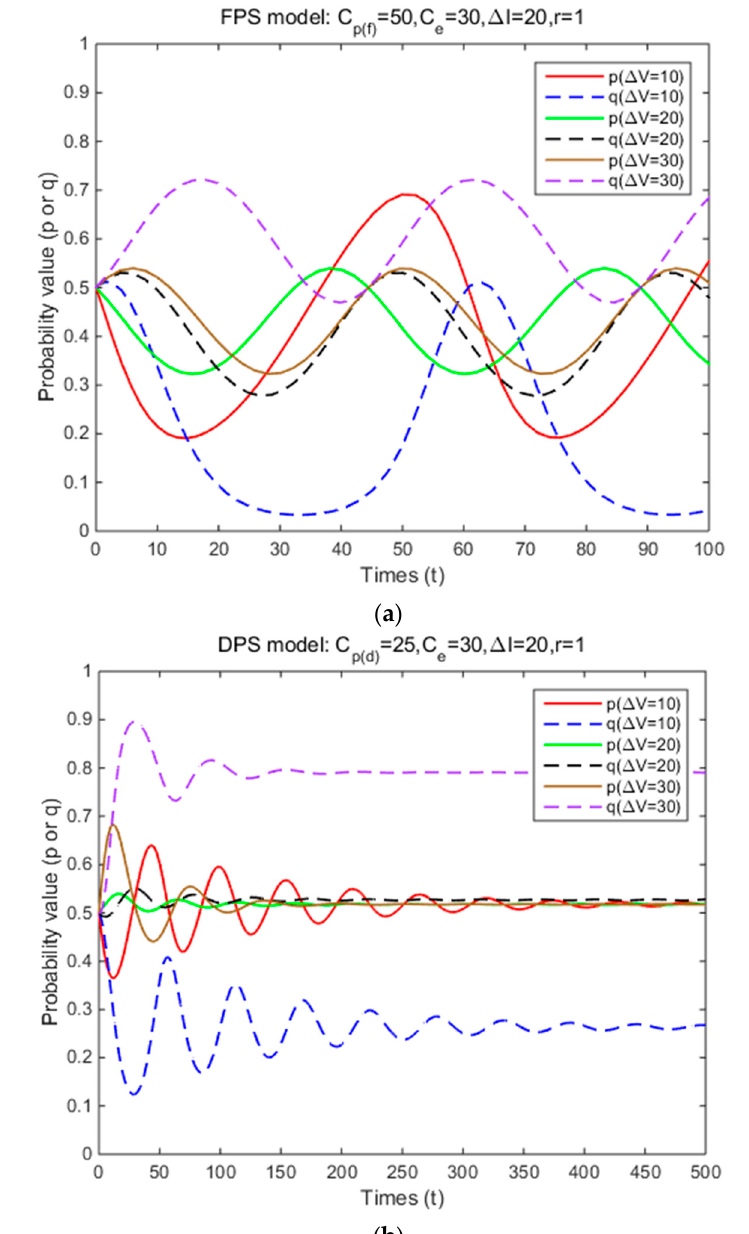
Figure5. Thee ff ectsofperceivedrelativebenefitonstrategyprobabilitiesofcyclistsandlawenforcement under FPS ( a ) and DPS ( b ) (Situation